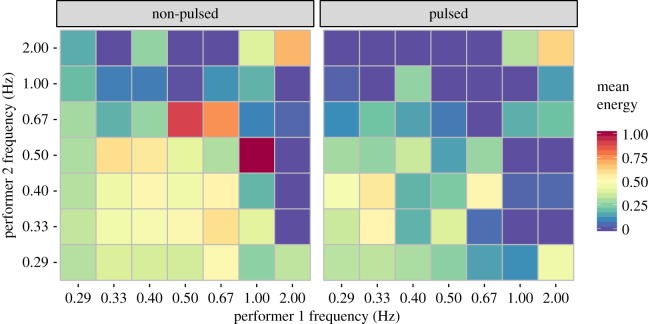
Co-occurring movement frequencies across the datasets. The axis labels denote the centre frequencies of the non-overlapping frequency bands used in the analysis.